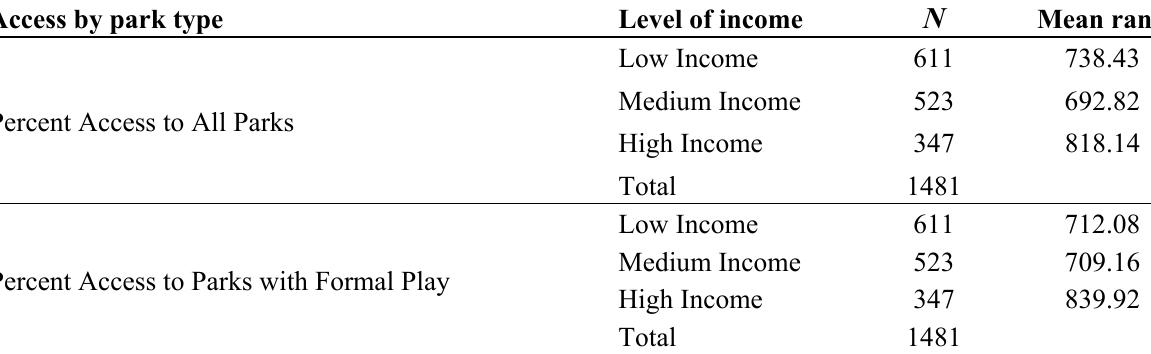
Table 3. Mean ranks of access to different types of parks by income groups from the Kruskall-Wallis H